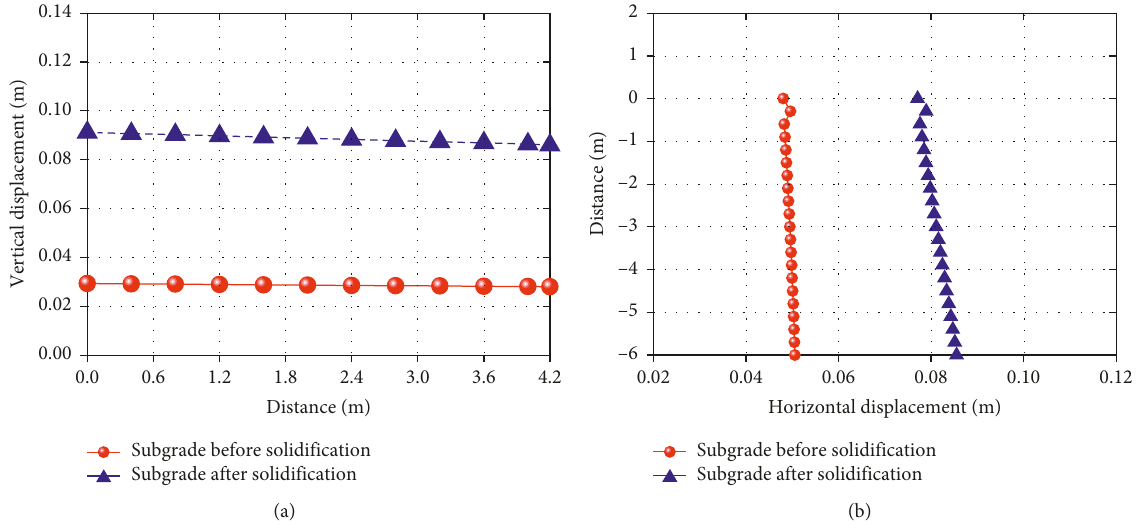
Figure 15: Settlement displacement of the subgrade top and the horizontal displacement of the right slope. (a) Subgrade top. (b) The right slope.